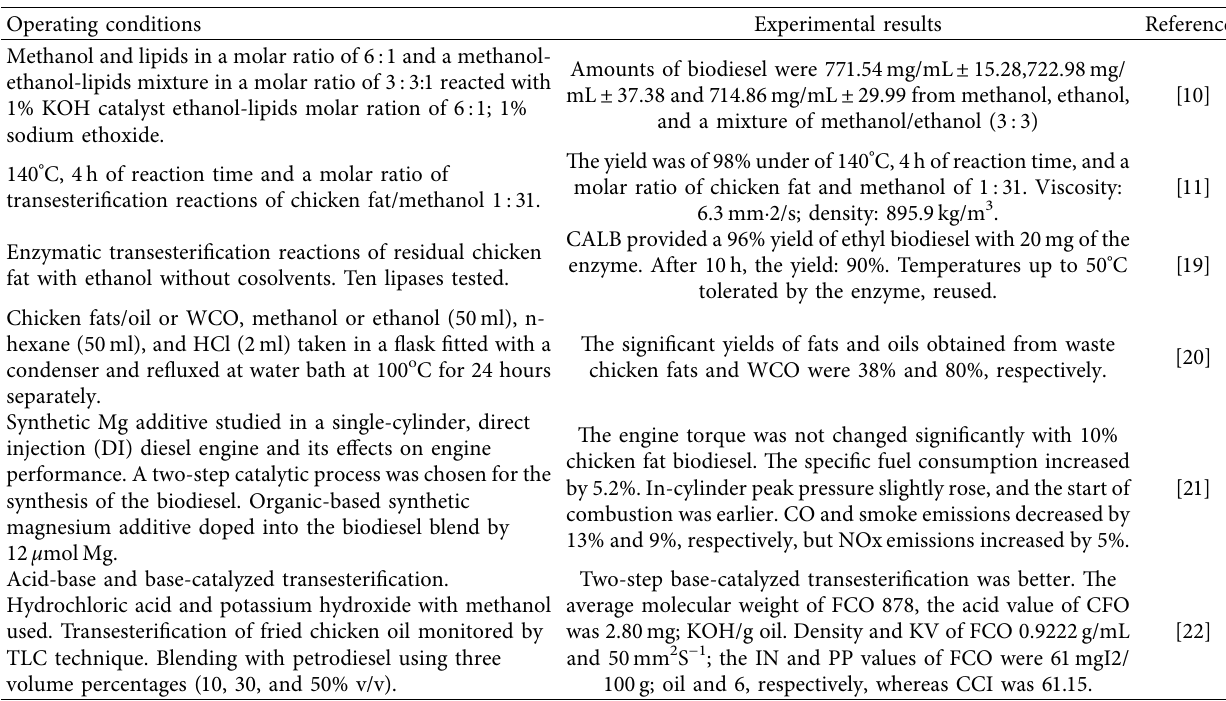
Table 1: Summary work on obtaining biodiesel by transesterification of chicken